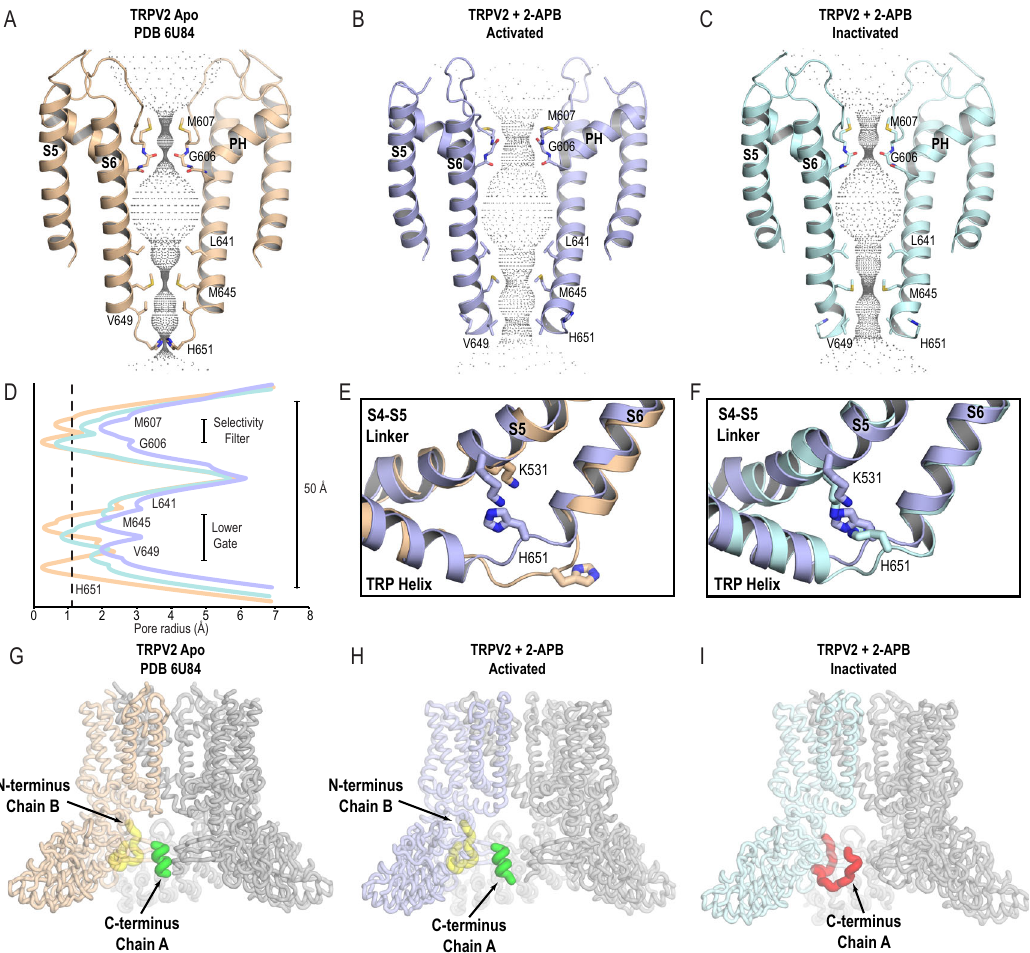
Fig. 1 2-APB-bound TRPV2 in activated and inactivated states. HOLE-generated pore pro fi les of TRPV2 Apo1 (PDB 6U84) ( A ), TRPV2 2APB_AC ( B ), and TRPV2 2APB_IAC ( C ). D Graphical representation of the pore pro fi les of TRPV2 Apo1 (wheat), TRPV2 2APB_AC (light blue), TRPV2 2APB_IAC (light cyan). The radius of a dehydrated calcium ion is marked by a dotted gray line at 1.1 Å. E , F His651 is inserted into the pore in the apo state (TRPV2 Apo1 , wheat), but rotates out of the central channel of the pore on channel activation (TRPV2 2APB_AC , light blue) to form a cation – π bond with Lys531. During channel inactivation (TRPV2 2APB_IAC , light cyan), His651 remains stably rotated out of the pore. TRPV2 Apo1 ( G ) and TRPV2 2APB_AC ( H ) feature the active conformation of the cytoplasmic regulatory switch, with the C-terminus forming a helix (green) inside the ankyrin repeat domain (ARD) skirt and the N-terminus (yellow) forming a loop at the multimerization interface between the β -sheet region and an ARD. TRPV2 2APB_IAC ( I ) features the inactive conformation of the cytoplasmic regulatory switch, with the C-terminus (red) forming a loop that wraps around the β -sheet